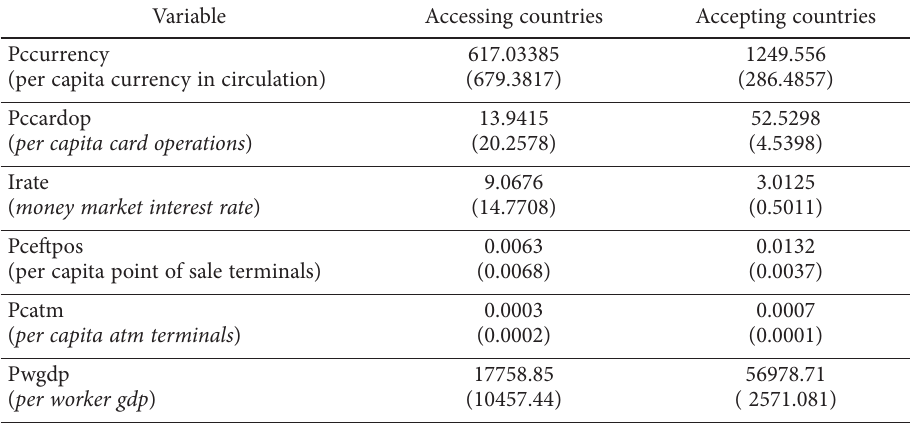
Table 1. Definitions of variables and descriptive